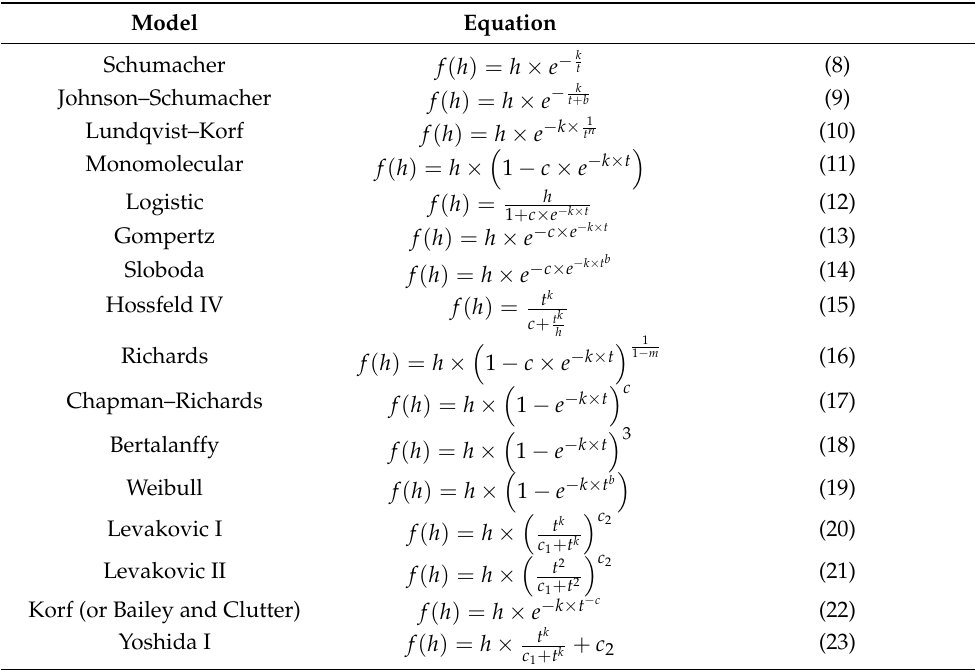
Table 2. Growth equations, where h —height, e —Euler’s number (approximately 2.71828); t —time; k , b , n , m and c —parameters such as number of samples, constants, and nonlinear coefficients, as described by Zeide, Burkhart and Tom é